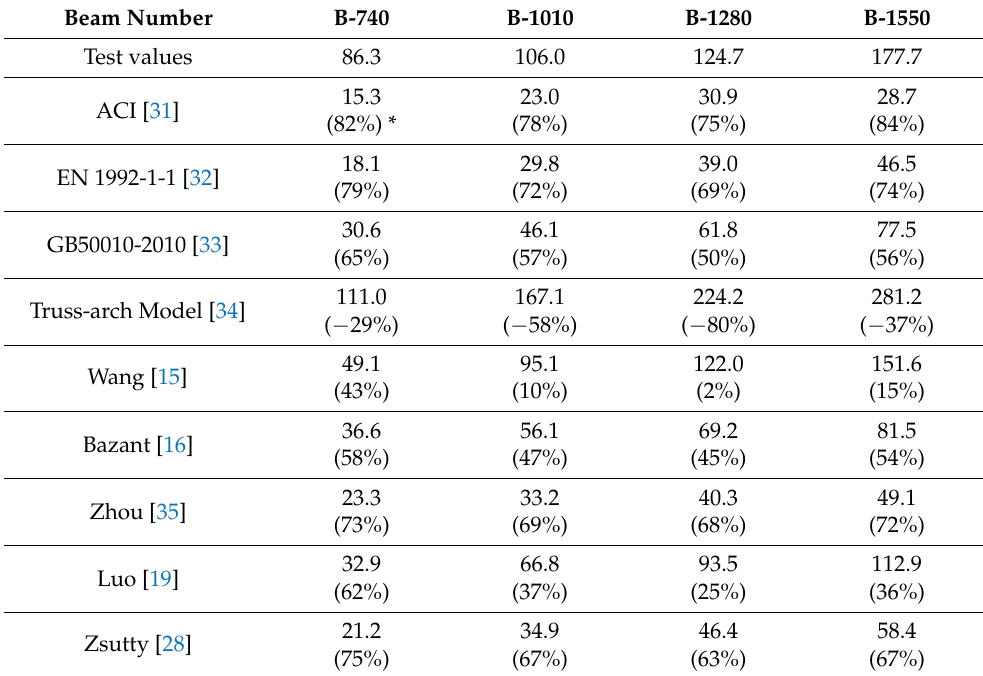
Table 8. Shear capacities obtained by the experiment and theoretical formulas